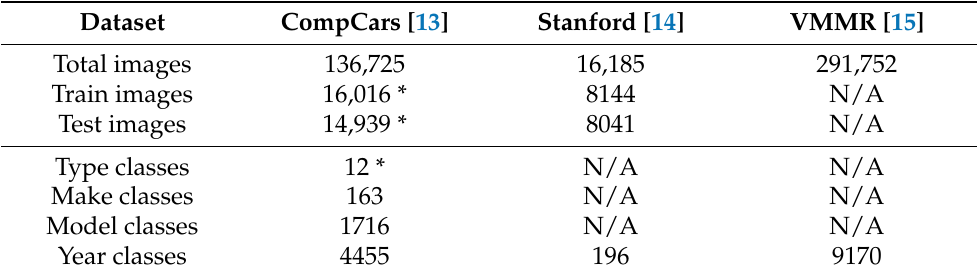
Table 1. Summary of the dataset characteristics for car classification. Figures marked with * indicate that the information is only available for part of the